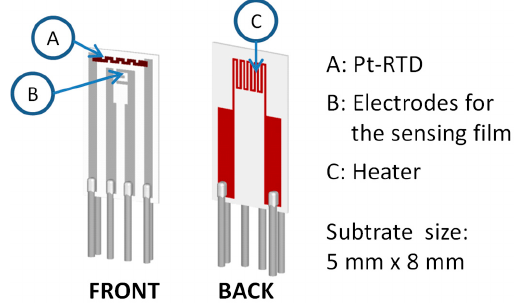
Figure 6. Alumina substrate.